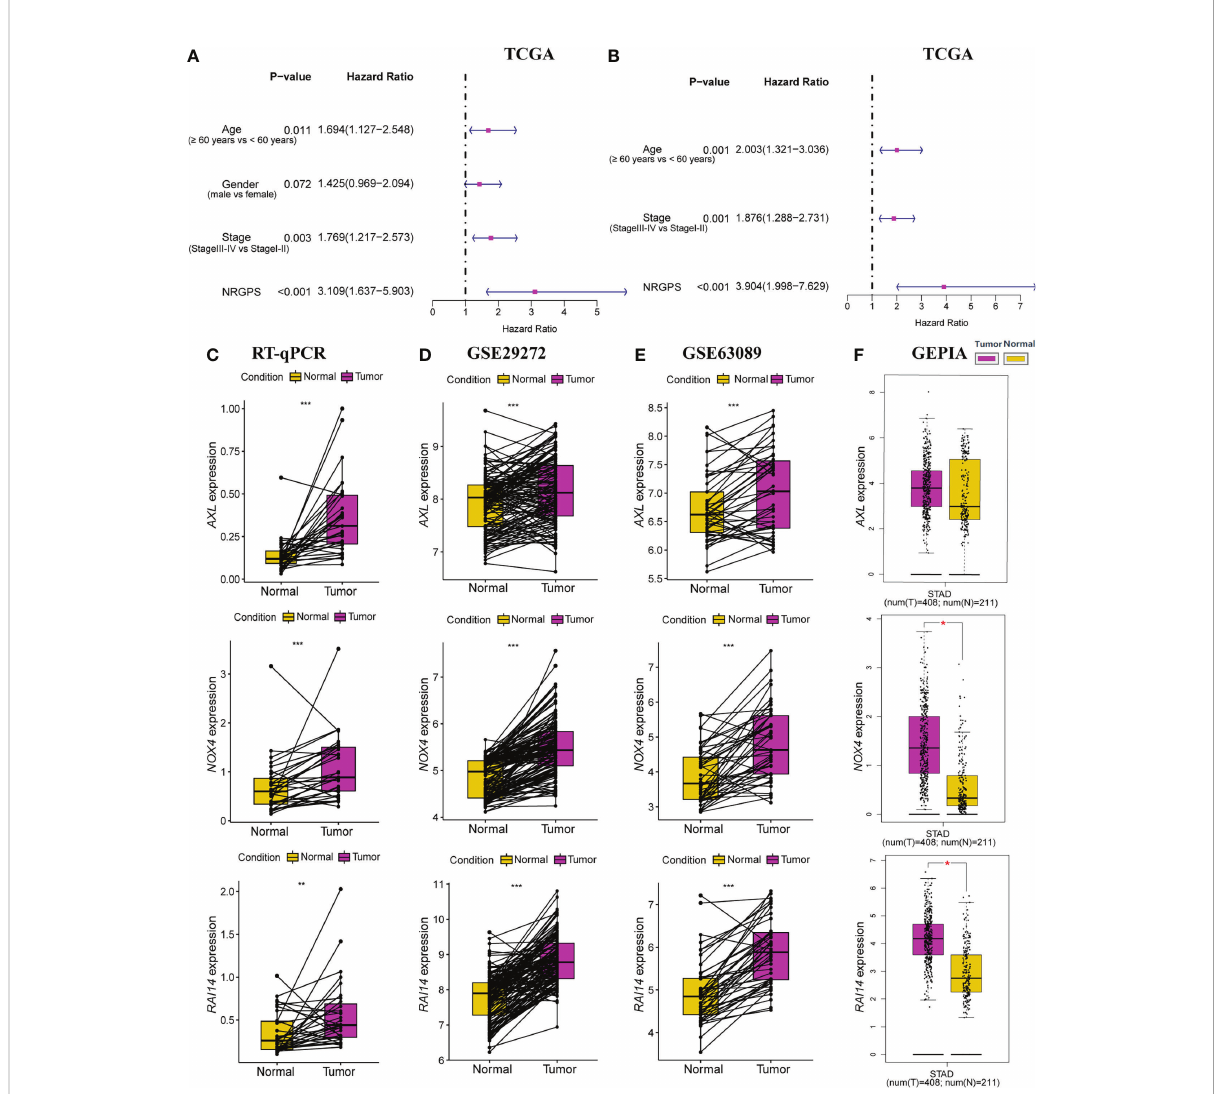
FIGURE 4 Independent prognostic analysis of prognostic model in TCGA cohort was performed. (A) The forestplot of univariable Cox regression analysis of NRGPS and clinical characteristics in TCGA cohort. (B) The forestplot of multivariable Cox regression analysis of NRGPS and clinical characteristics in TCGA cohort. (C) RT-qPCR was used to detect the relative mRNA levels of three NRGs in GC and adjacent normal tissues. (D) Relative mRNA levels of three NRGs in GC and adjacent normal tissues in GSE29272 dataset. (E) Relative mRNA levels of three NRGs in GC and adjacent normal tissues in GSE63089 dataset. (F) Relative mRNA levels of three NRGs in GC and adjacent normal tissues in GEPIA dataset. NRGPS, necroptosis-related gene prognostic score; NRG, necroptosis-related genes; GEPIA, Gene Expression Pro fi ling Interactive Analysis. * p < 0.05, ** p < 0.01, *** p <